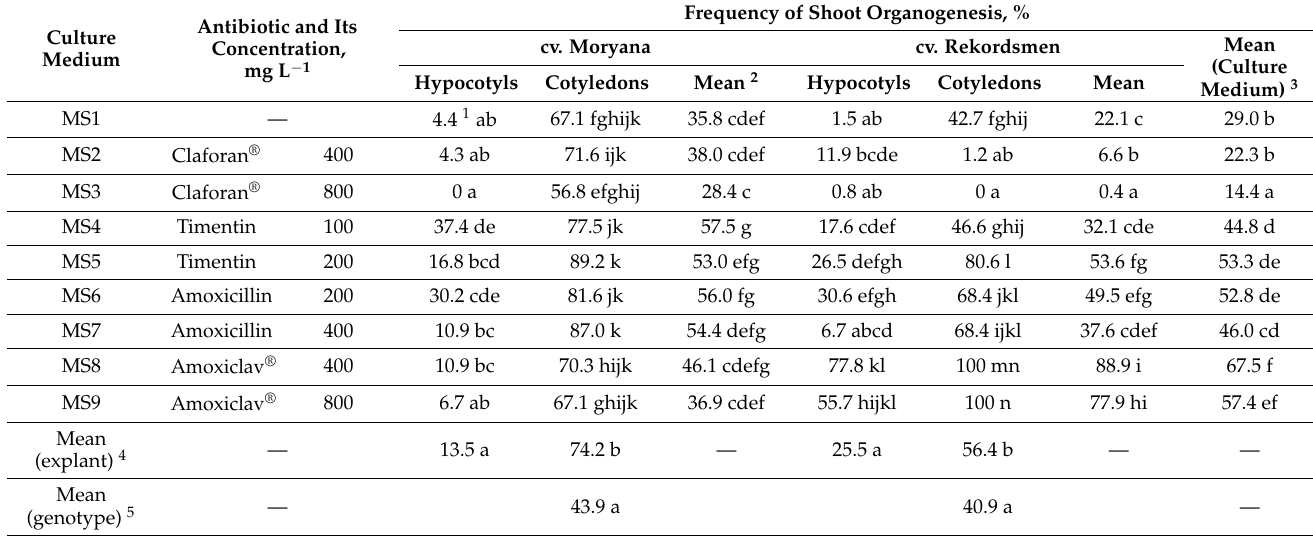
Table 2. The effects of genotype, explant type, and culture medium components on the frequency of tomato shoot organogenesis in vitro.